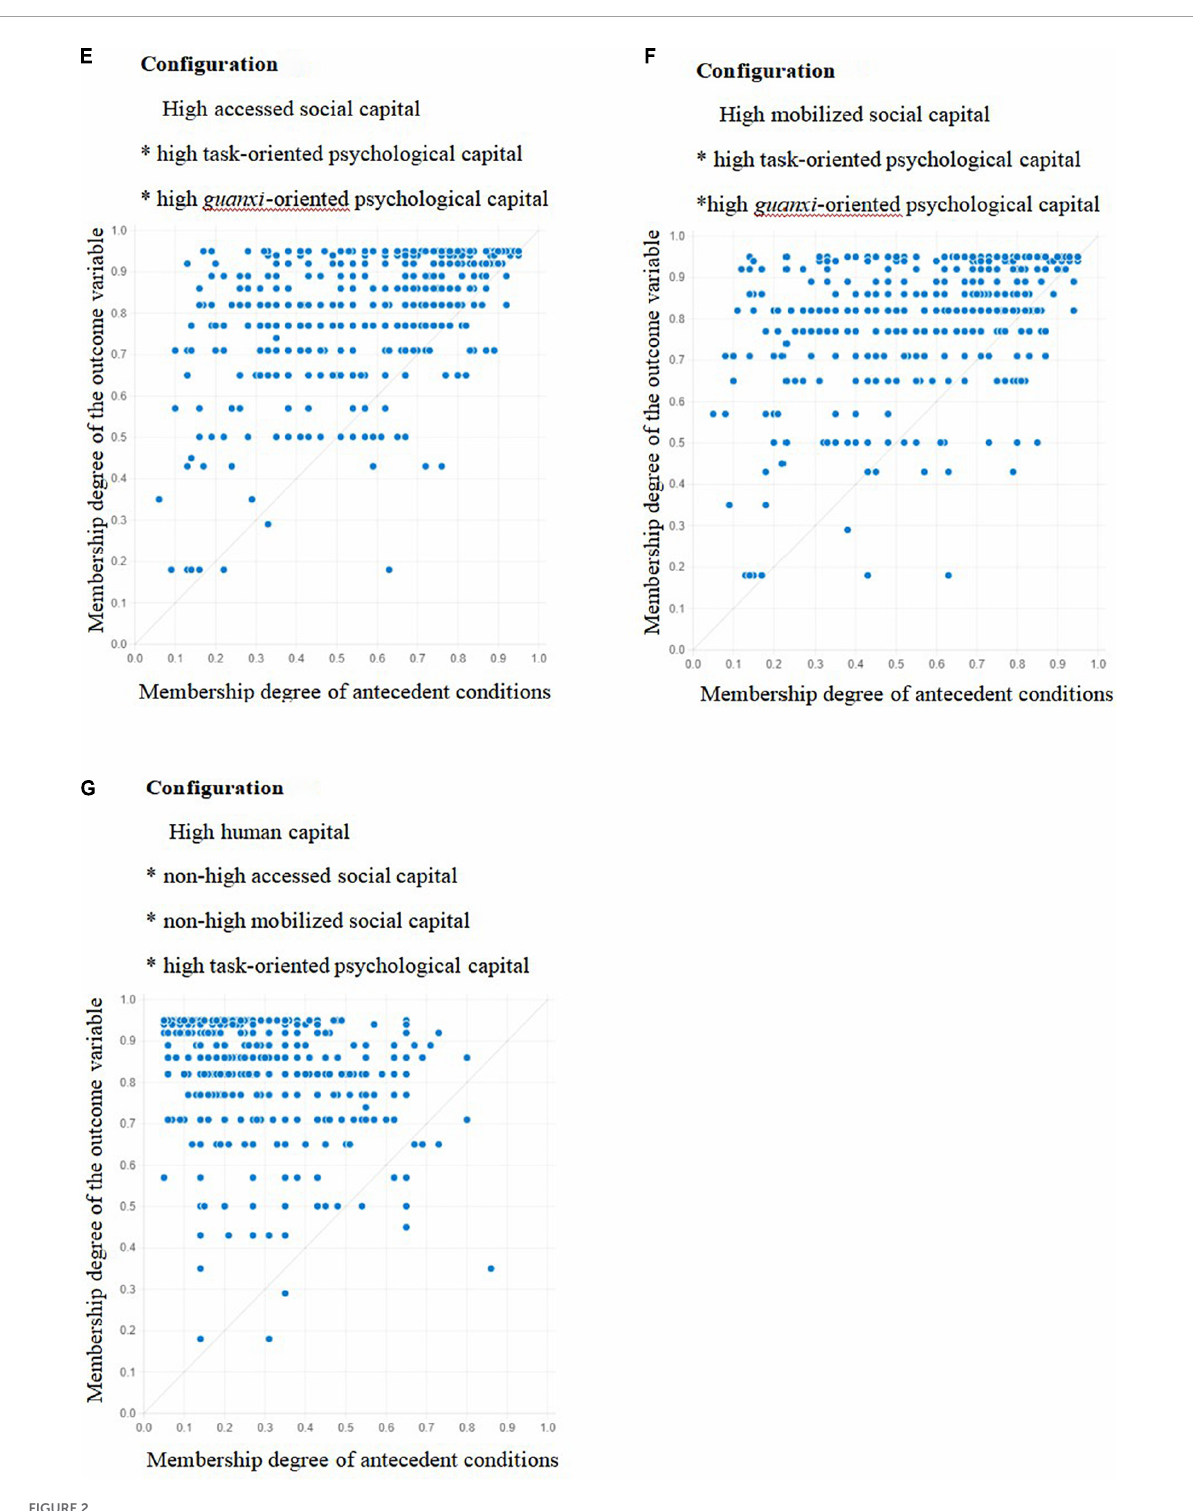
FIGURE2 Fuzzy subset relation diagrams for Configurations E–G , and contextual